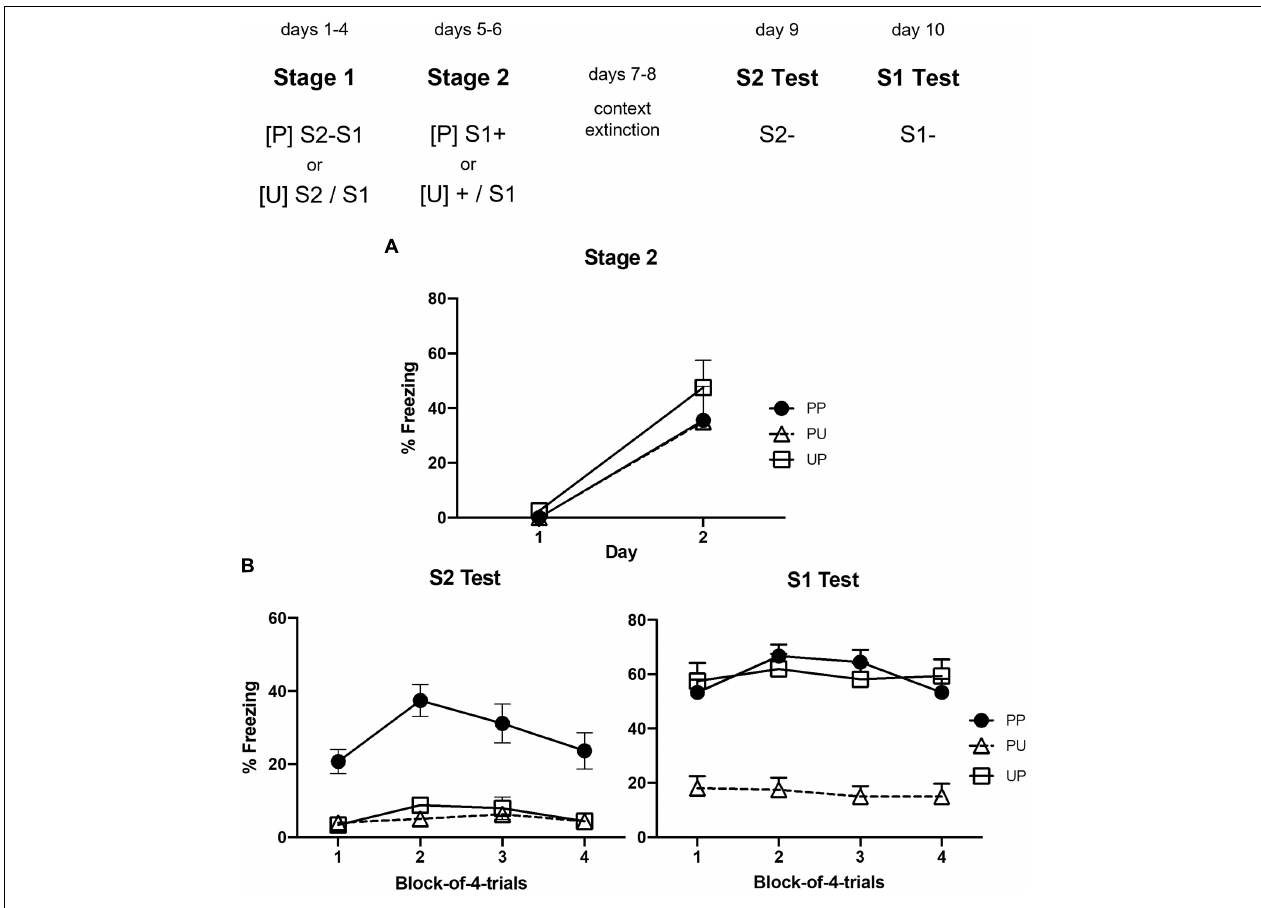
FIGURE 3 | Results of Experiment 2a showing that freezing to S2 is due to sensory preconditioning. (A) Shows the mean (+ SEM) levels of freezing to S1 in stage 2. (B) Shows the mean (+ SEM) levels of freezing during the final drug-free tests across blocks of four S2 alone trials (left panel) and four S1 alone trials (right panel). The numbers of rats in each group were: Group PP, n = 9; Group PU, n = 8; and Group UP, n =